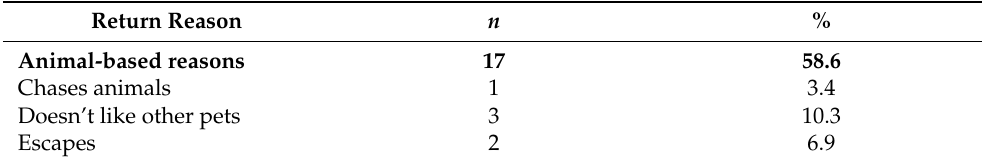
Table 2. Return reasons ( n =